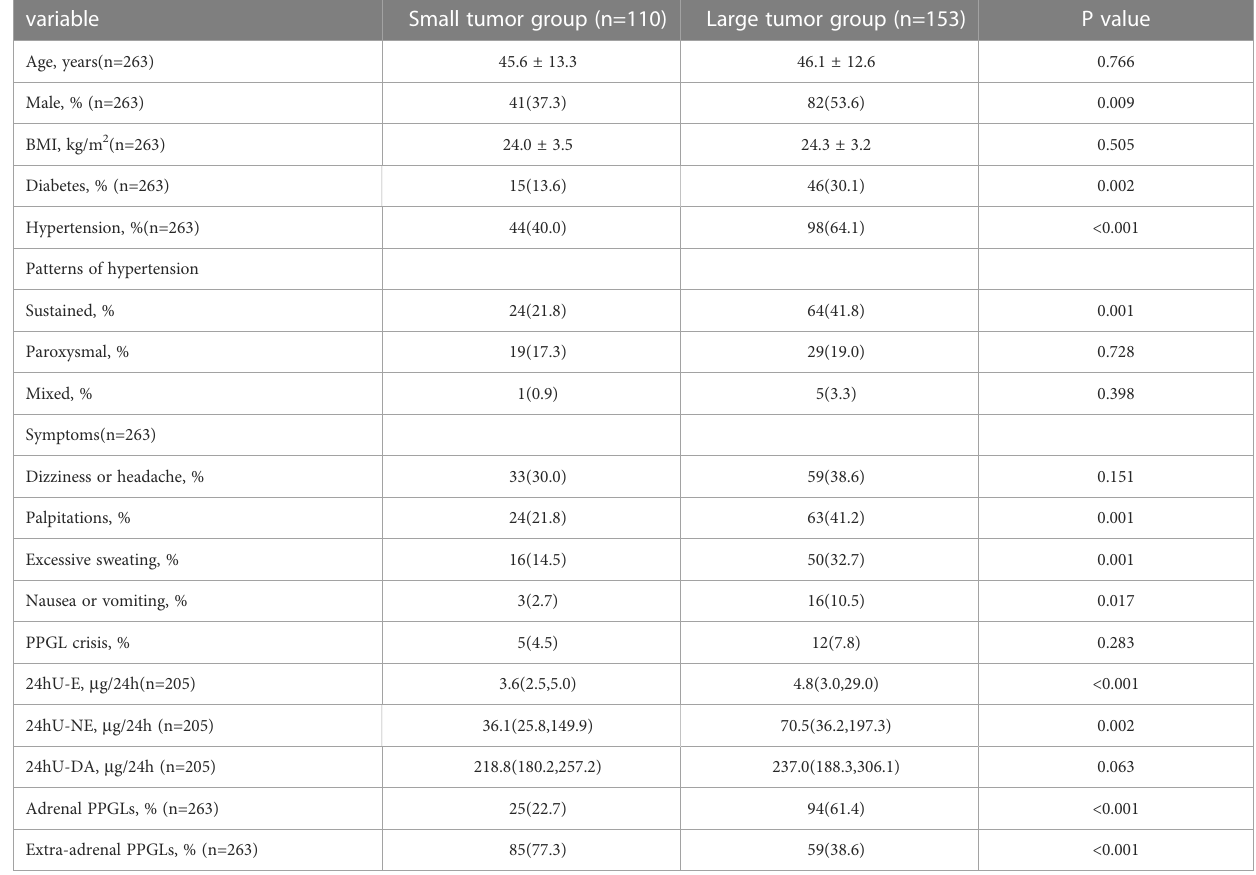
TABLE 2 Clinical characteristics of patients between the two groups.